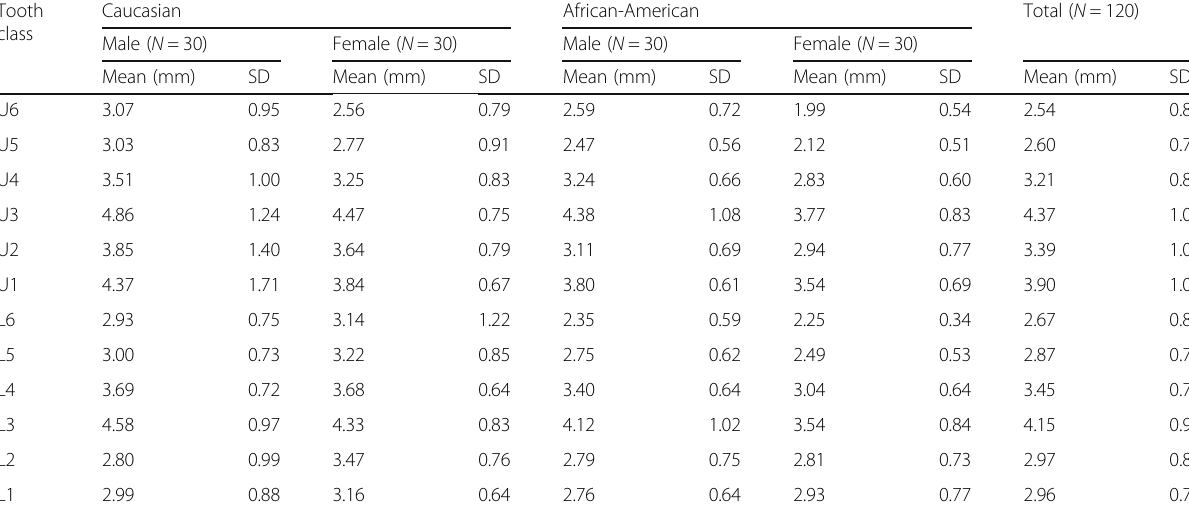
Table 2 Gingival margin-papillae means ± SD for the subgroups Tooth